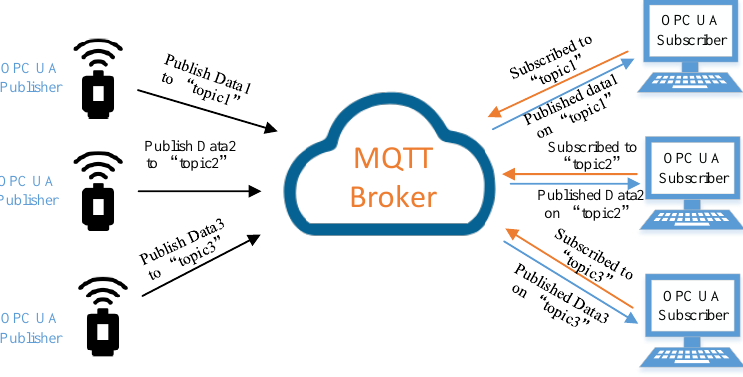
Figure 2. Broker-based OPC UA pub/sub communication architecture.